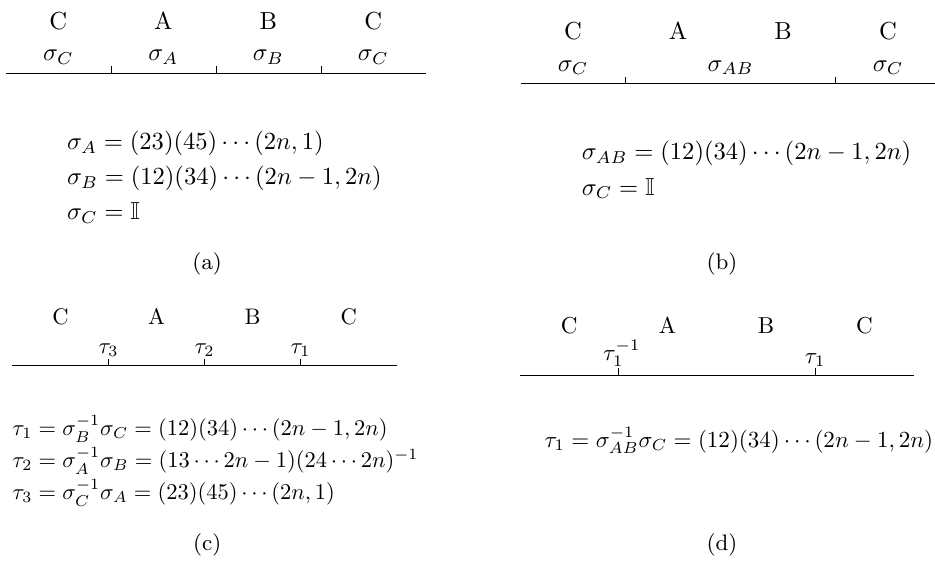
Figure 12 . Domain walls in state and operator R(cid:19)enyi entanglement. The spin boundary conditions at the top boundary of the tenor network are shown for (a): operator R’enyi entanglement and (b): state entanglement. (c)/(d): the corresponding domain walls at the top boundary for operator/state entanglement. Notice the resemblance of domain walls to the twist (cid:12)elds in eq. (2.2).